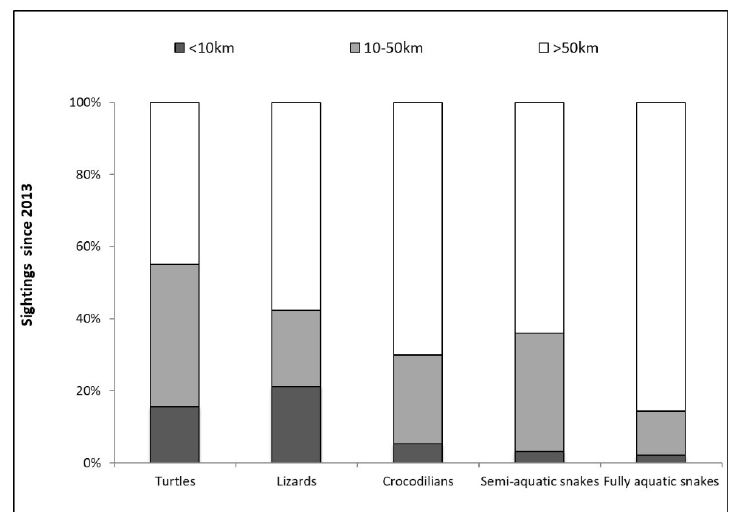
Figure 8. Freshwater reptile species sightings from GBIF (2013–2018) in each major group by the distance the center of a city. No shading represents the percentage sightings made at more than 50 km from a city center.